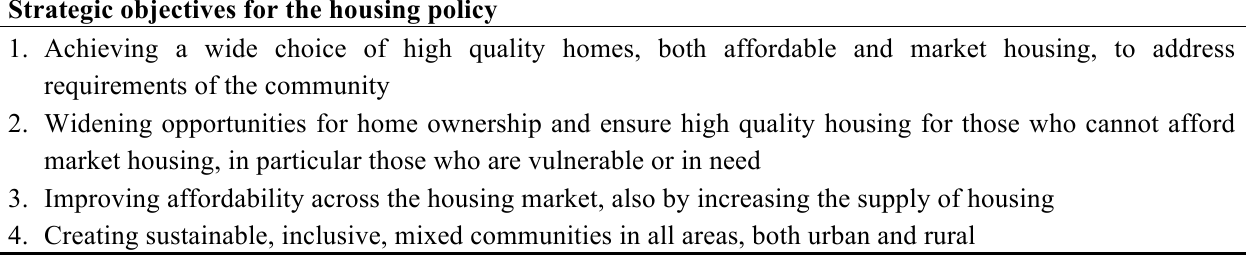
Table 3. Housing policy with focus on sustainable development, in PPS3